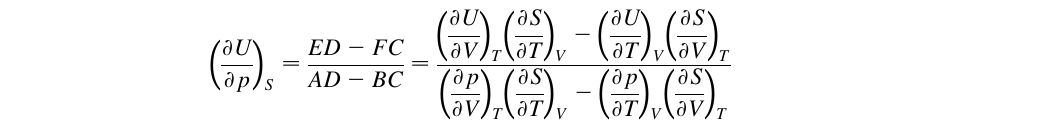
Partial Derivatives game (see Table